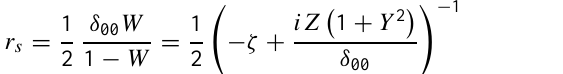
Fig. 2 Fig. 2. The amplitude squared (a) and phase (b) of the multiple scatter coupling function, r , as a function of coordinate, ζ